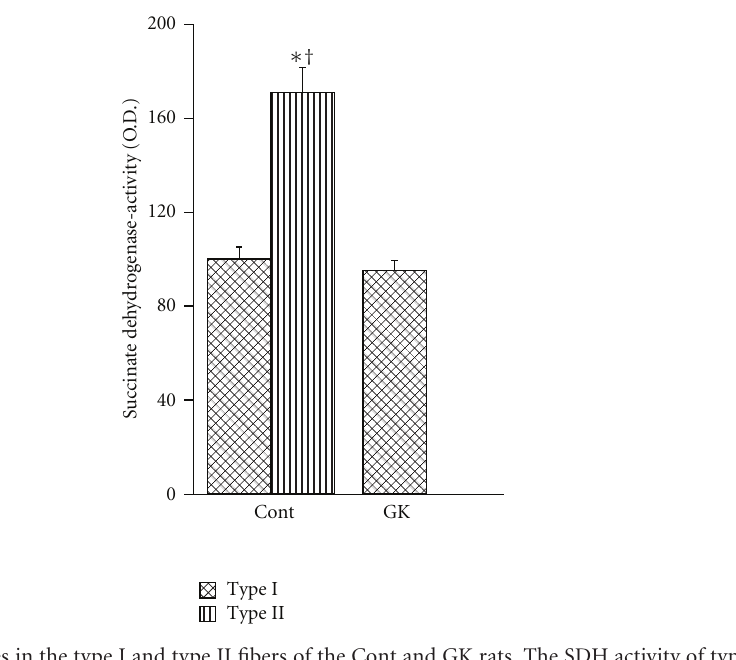
Figure 3: The mean SDH activities in the type I and type II fibers of the Cont and GK rats. The SDH activity of type II fibers of the Cont rats is significantly higher than that of type I fibers of the Cont and GK rats. ∗ P < 0 . 05 compared with type I fibers of Cont rats. † P < 0 . 05 compared with type I fibers of GK